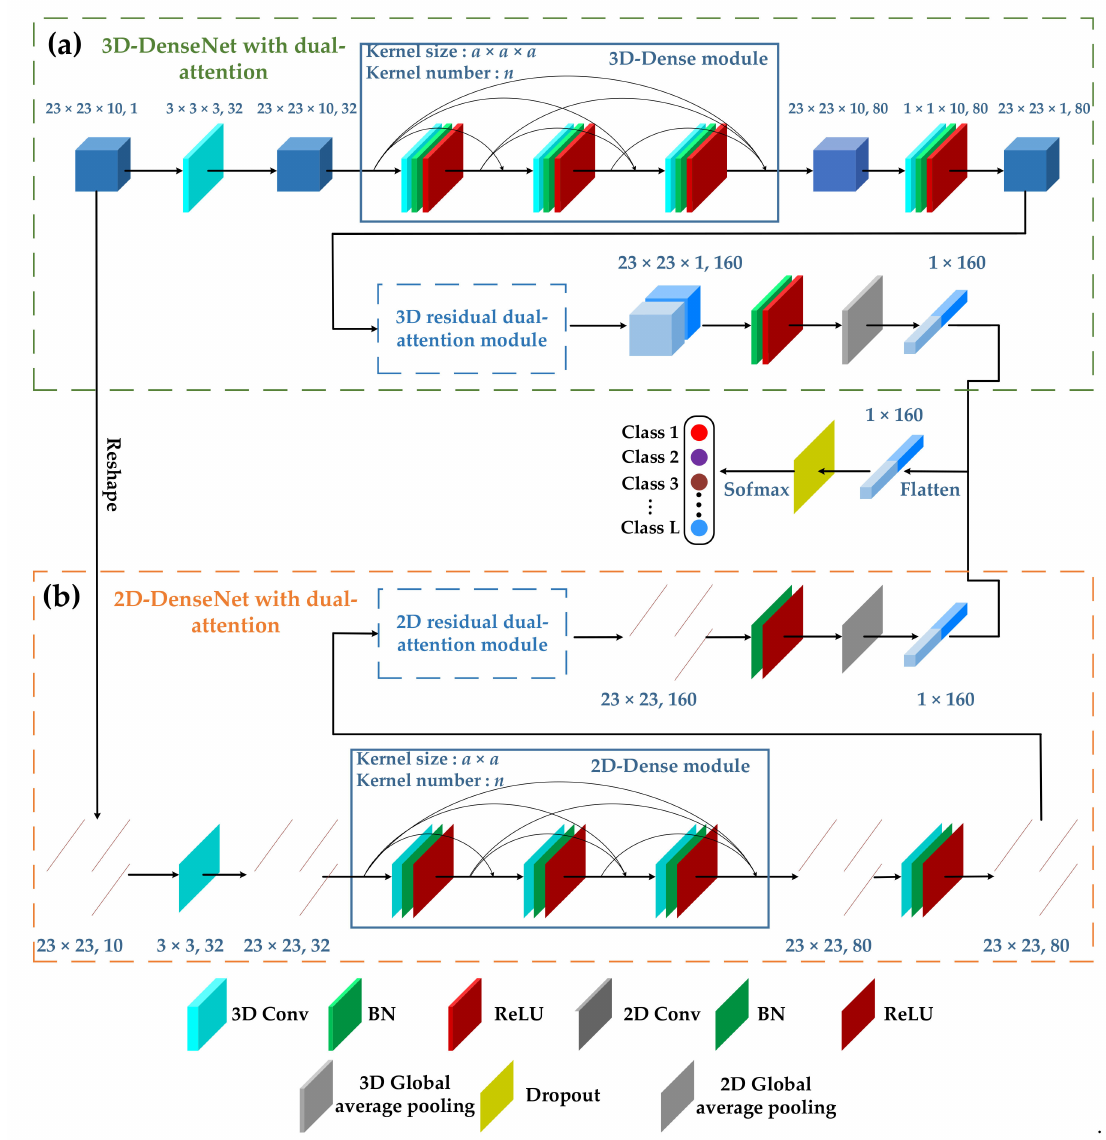
Figure 8. Structure of the HDDA network: ( a ) 3D-DenseNet with dual attention; ( b ) 2D-DenseNet with dual